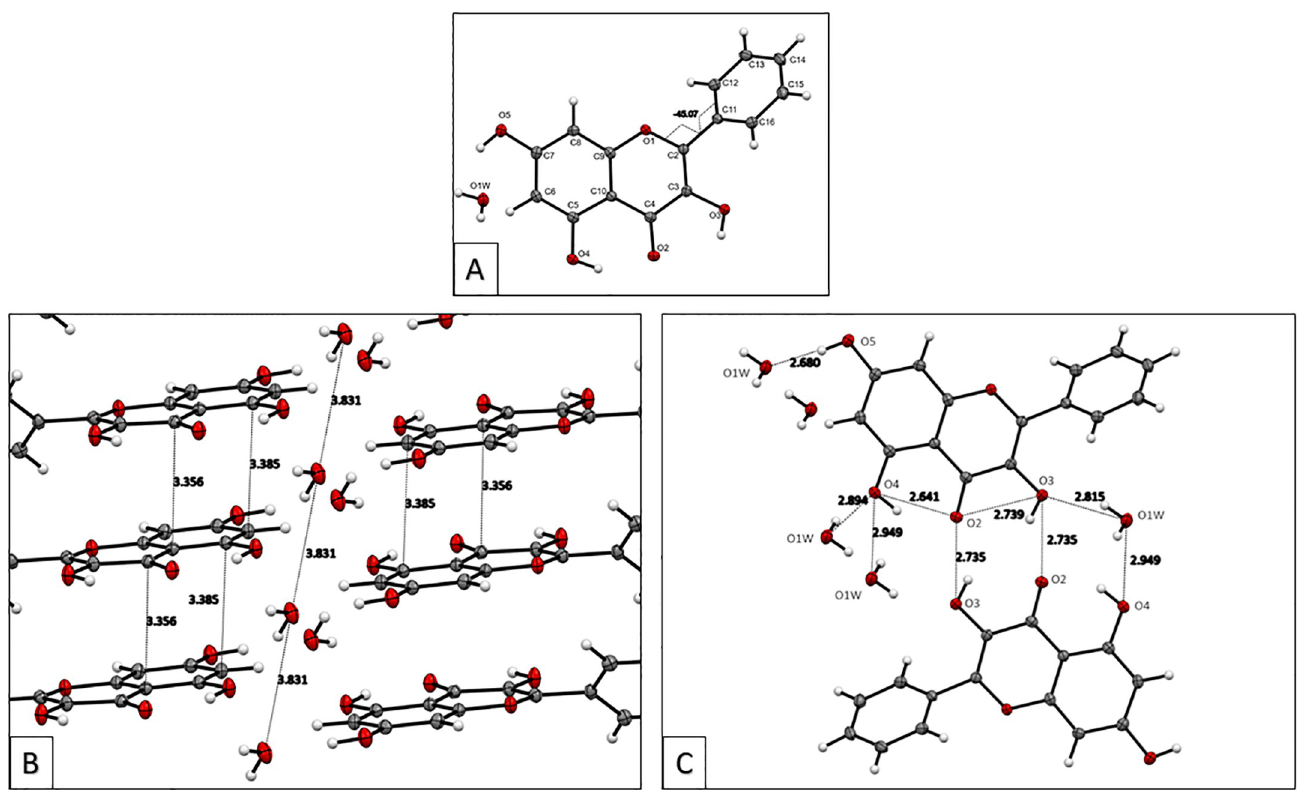
Fig 2. A: The asymmetric unit of galangin monohydrate with atom labeling and the torsion angle about the C2-C11 bond at -45.1(2˚; B: Offset stacking interactions among galangin molecules (about 3.35–3.38 Å ). The repeat distance between water molecules of 3.831 Å is equivalent to the unit cell a axis length; C: Distances of hydrogen bonding interactions in the galangin crystal structure.